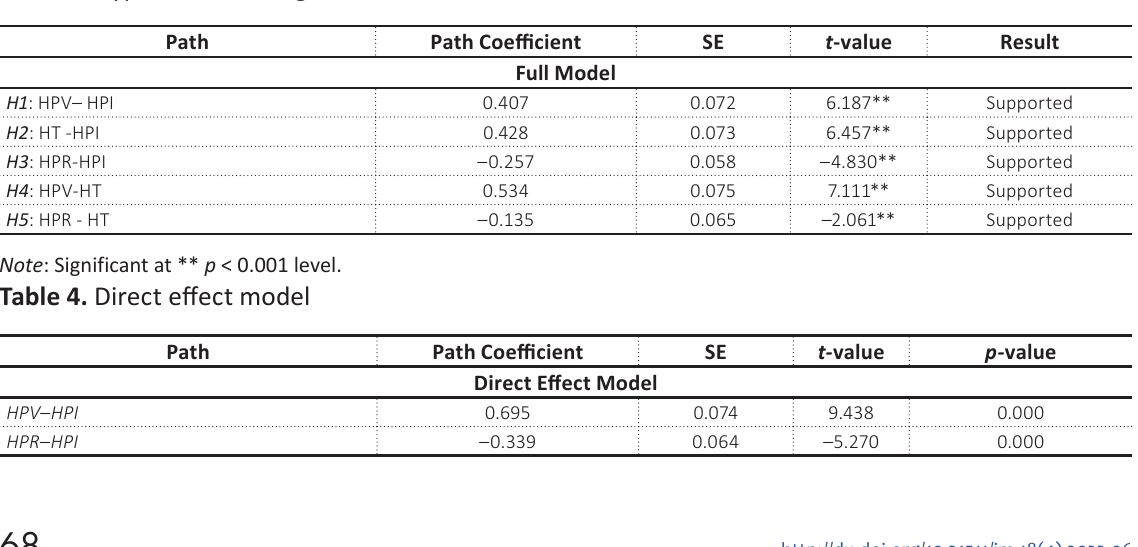
Table 3. Hypotheses testing